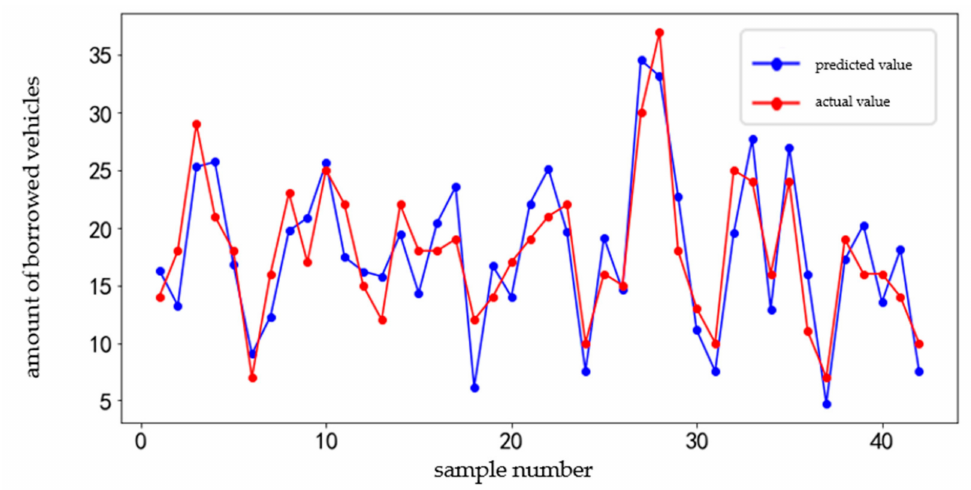
Figure 14. Prediction comparison chart of station collection 1.